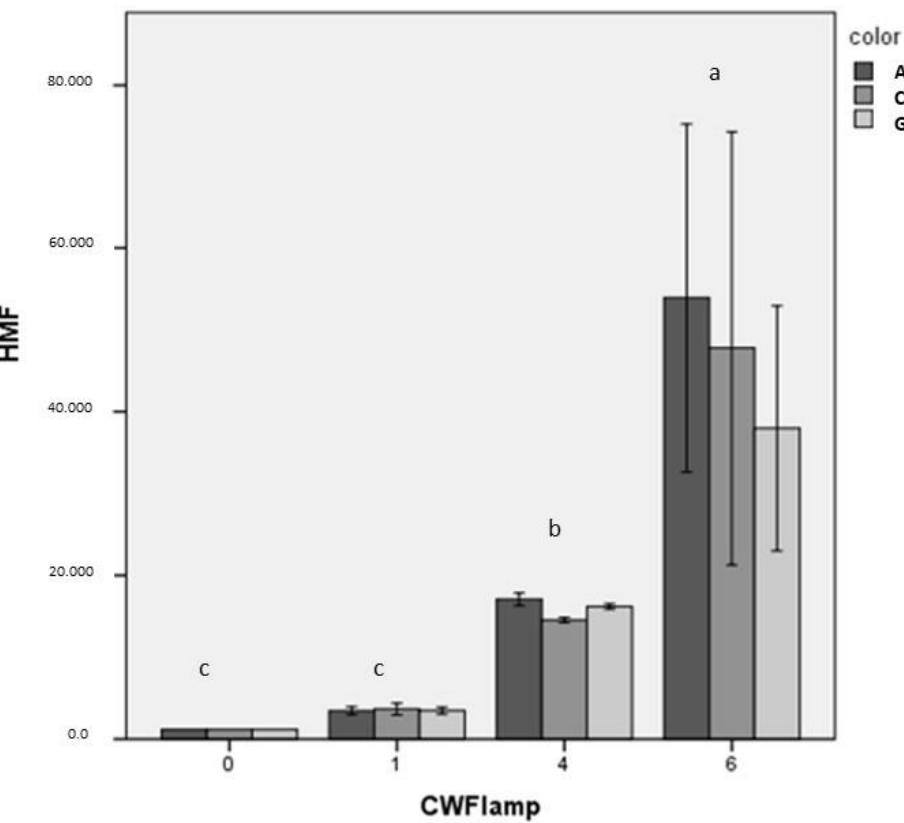
Figure 2. HMF concentration at constant temperature of 25 °C influenced by the number of CWF lamps (0, 1, 4, 6) and the color of clear glass bottles (amber, colorless, green); different letters represent significant differences (LSD test, P ≤ 0.05).